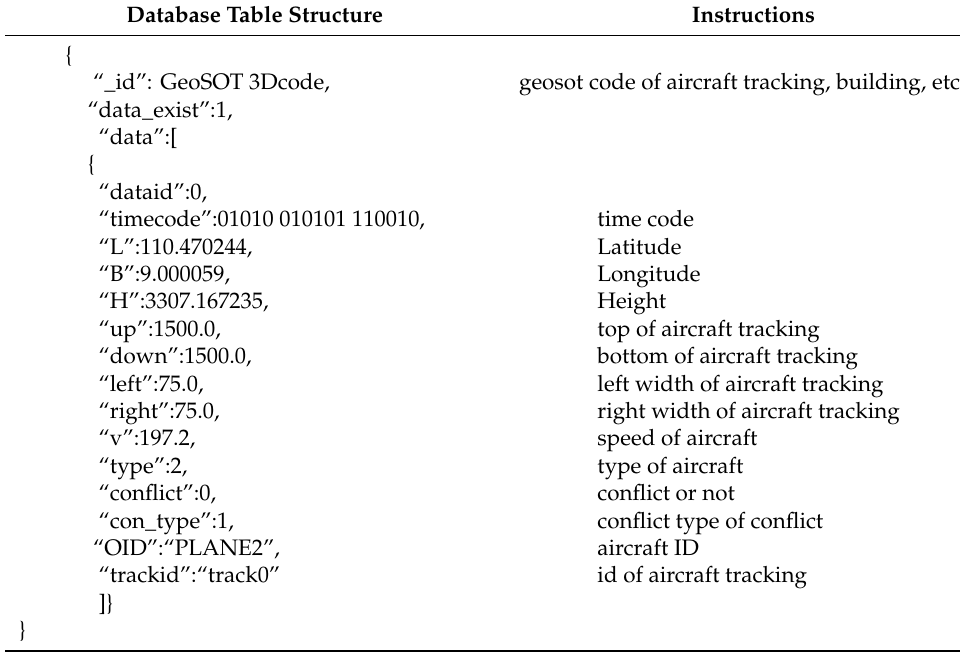
Table 2. Database Table Structure Design 1 of the aircraft trajectory.